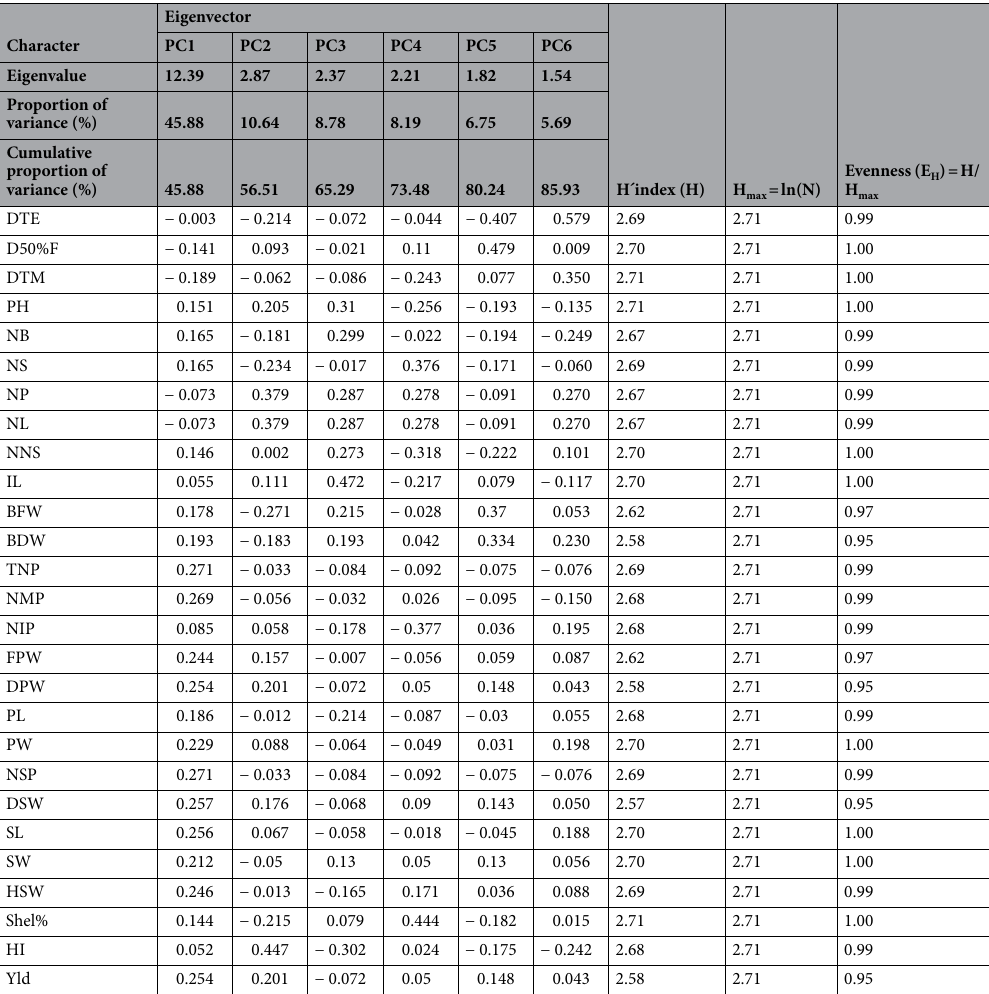
Table 9. Eigenvectors and values for the first six principal component axes for 27 agronomic traits associated Bambara groundnut accessions. DTE (day) days to emergence, D50%F (day) days to 50% flowering, DTM (day) days to maturity, PH plant height (cm), NB number of branches per plant, NS number of stems per plant, NP number of petioles per plant, NL number of leaves per plant, NNS no. of nodes per stem, IL (cm) inter nodes length, BFW(g) biomass fresh weight per plant, BDW(g) biomass dry weight per plant, TNP total no. of pods per plant, NMP number of mature pods per plant, NIP number of immature pods per plant, FPW(g) fresh pods weight, DPW(g) dry pods weight, PL(mm) pod length, PW (mm) PW, NSP no. of seeds per plant, DSW(g) dry seed weight per plant, SL(mm) seed length, SW (mm) seed width, HSW(g) hundred seed weight, Shel% shelling percent, HI (%) harvest index, Yld yield (kg ha −1 ) ; H Shannon diversity, N no. of